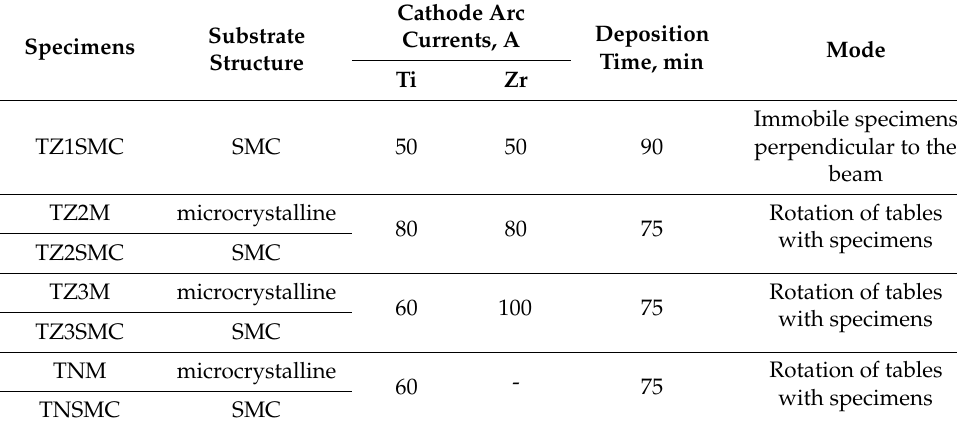
Table 1. Technological parameters of coating deposition